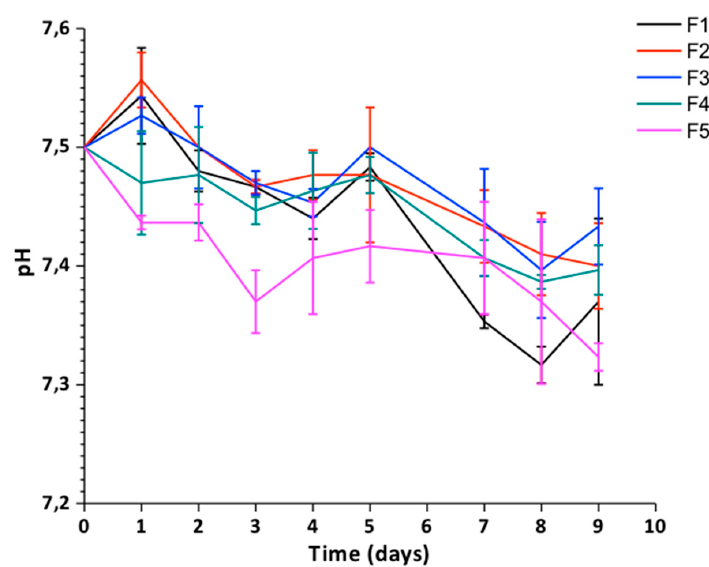
Figure 8. Study of the pH solution vs. immersion time in simulated body fluid (SBF) of the films. F1: CS/PVA/GO 20:80:0; F2: CS/PVA/GO 14.75:85:0.25; F3: CS/PVA/GO 19.5:80:0.5; F4: CS/PVA/GO 14.25:85:0.75 and F5: CS/PVA/GO 29:70:1. All the ratios are wt %. Data are shown as mean ± standard deviation of the mean ( n = 3).